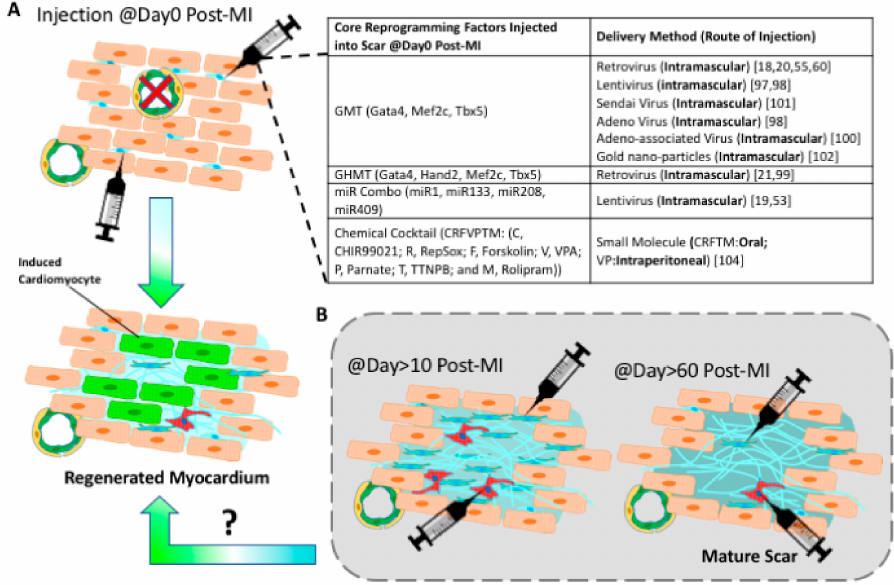
Figure 3. Progresses and challenges of in vivo reprogramming. ( A ) Cardiac reprogramming factors were all delivered right after acute myocardial infarction. The inserted table summarizes in vivo reprogramming studies that use various viral or chemical cocktails [18–21,53,55,60,97–102,104]. ( B) It is unknown if a cardiac chronic scar can be reprogrammed into induced cardiac muscle